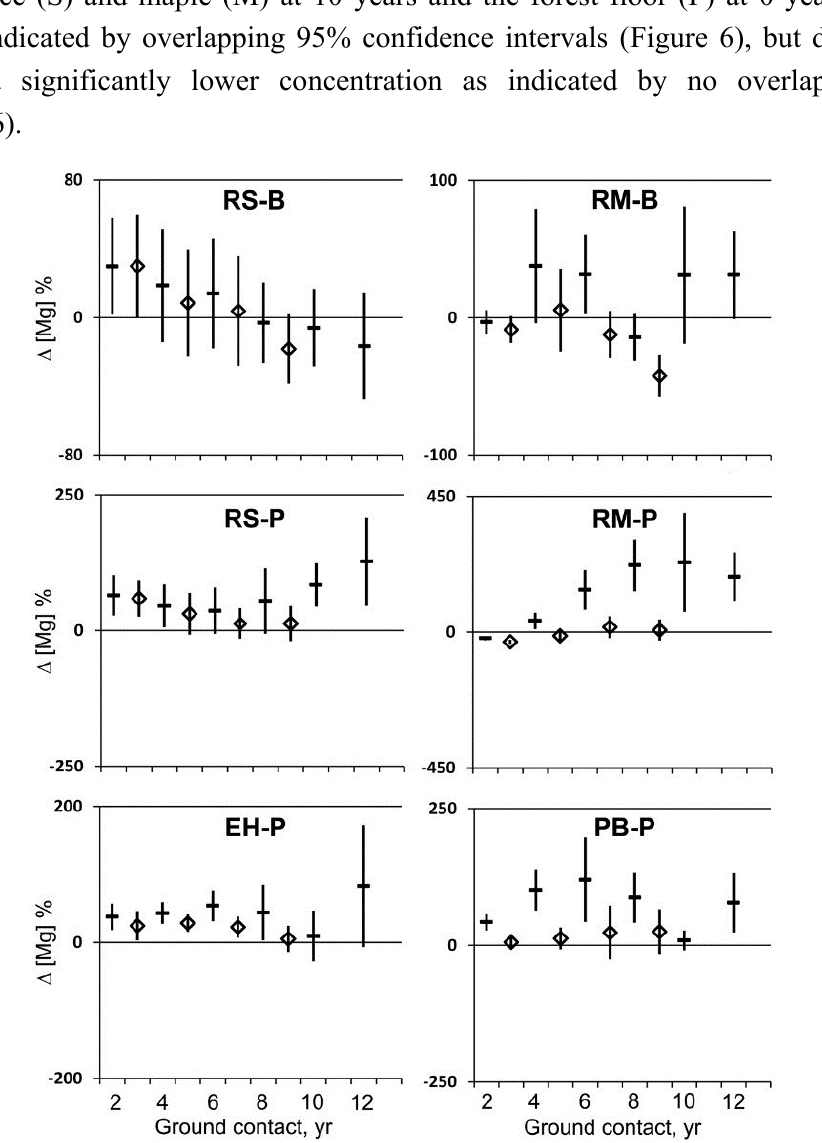
Figure 5. Mean change in magnesium concentration per unit mass (dash) and per unit volume (diamond) and 95% confidence interval ( n = 20) for red spruce (RS), eastern hemlock (EH), red maple (RM), and paper birch (PB) at the Bartlett Experimental Forest (B) or the Penobscot Experimental Forest (P) during two to 12 years of decay with ground